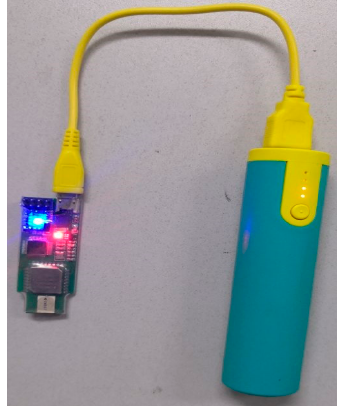
Figure 15. The UWB node.